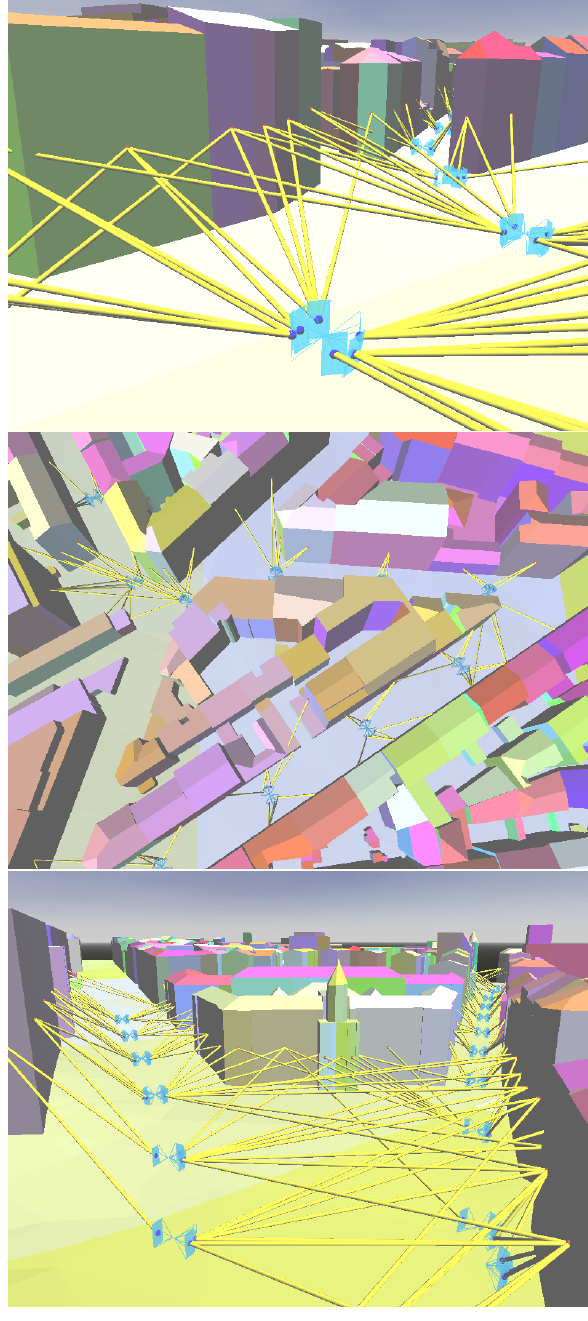
Figure 3: Various views of the visibility graph computed on our test scene (for clarity, only 10% of the images were used). Image (resp. scene) nodes are displayed in blue (resp.